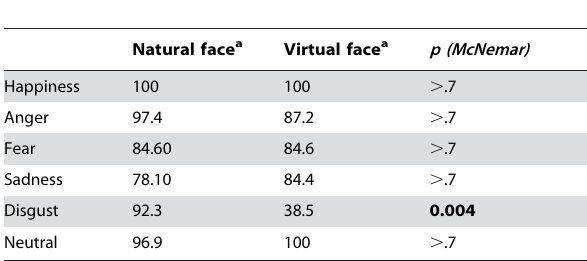
Table 1. Accuracy rates in % for best recognized faces.